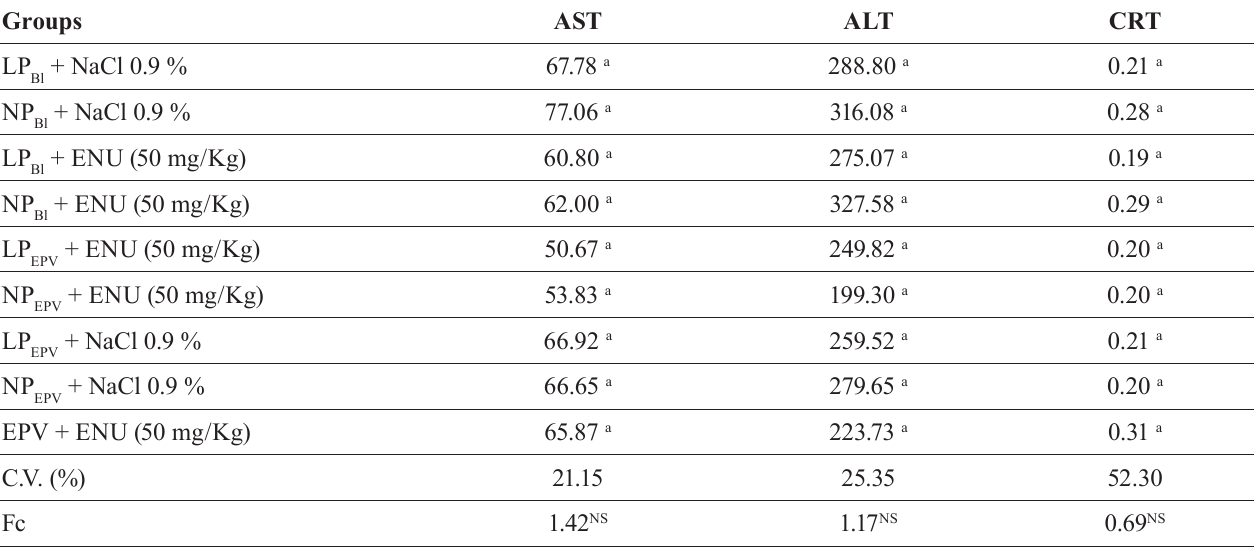
TABLE V - B iochemical analysis of the hepatic (AST and ALT) and renal (CRT) activities of control and treated with Pyrostegia venusta ethanolic extract groups during 15 days